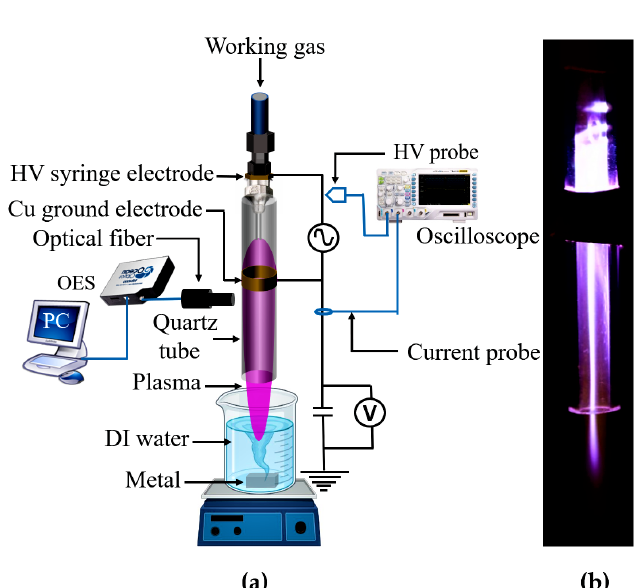
Figure 12. ( a ) Schematic of the atmospheric-pressure nitrogen plasma jet. ( b ) Photograph of the plasma